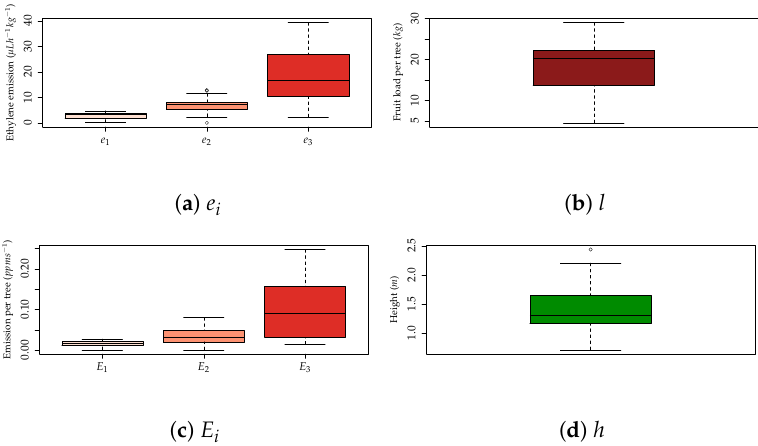
, , and stand for e , E e , E e , E { } 1 { } 2 { } 3